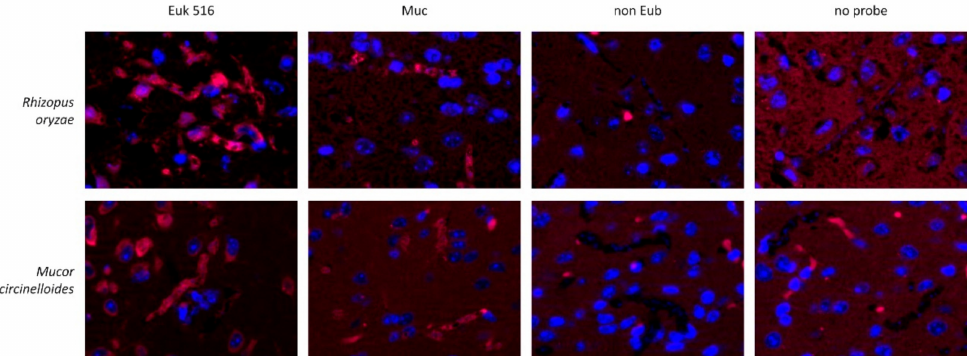
Figure 2. Evaluation of FISH probes targeting the ribosomal RNA of Mucorales with formalin-fixed, paraffin-embedded brain tissue from a mouse infection model. Mice were infected with either Rh. oryzae (upper) or M. circinelloides (lower). Hybridization with an unspecific probe targeting eu- karyotic cells (Euk 516, first column) was used as a positive control with good cytoplasmatic signal intensity of Mucorales hyphae and host cells. Hybridization with the Mucorales probe combination (Muc, second column) demonstrated selective hybridization of hyphae from Rhizopus oryzae and Mucor circinelloides with signal intensity in the fungal cytoplasm comparable with the positive probe but not host tissue. Hybridization with a nonsense probe (non Eub, third column) or with hybridiza- tion buffer without FISH probe (last column) demonstrates the absence of any fluorescence signal of fungal elements in the cytoplasm and cell wall. All probes are coupled with Cy5. Double-stranded DNA stained with DAPI. Identical exposure times were used for each